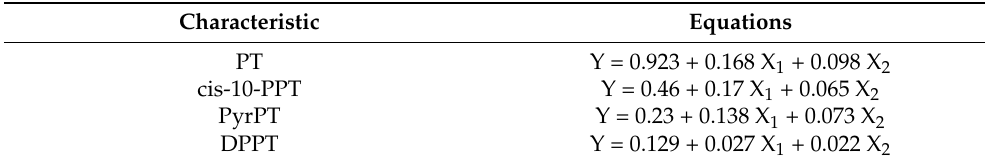
Table 2. The equations of the mathematical